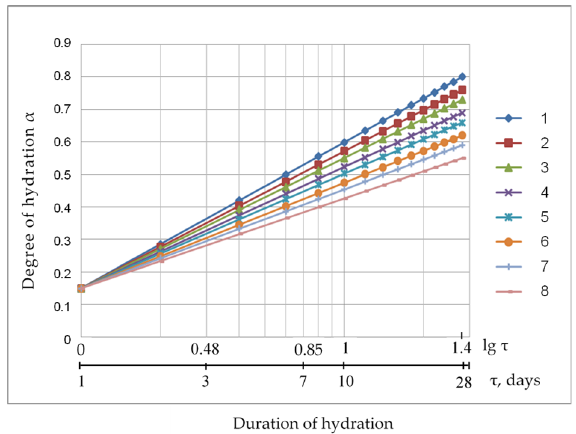
Figure 2. The influence of the hydration duration on the degree of hydration of composite cements (α) (line numbering is given for cements according to Figure 1).